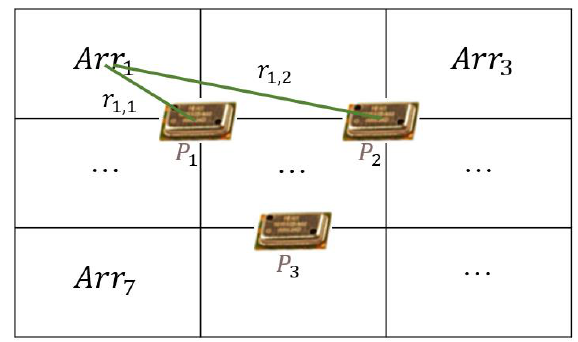
Figure 5. Parameters of arrival of time (AoT) algorithm.